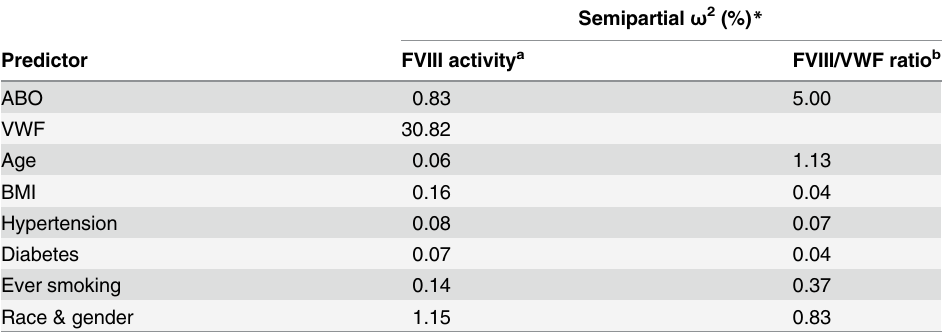
Table 5. Effect Size (%) of Covariates for FVIII activity and FVIII/VWF